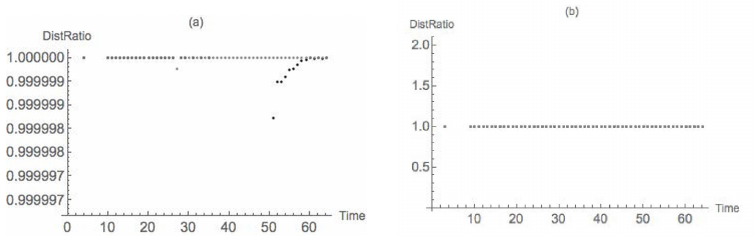
Figure 10. β 0 : Interpolation functions of ratios of bottleneck distance to Wasserstein-1 distance (black dots) and Wasserstein-2 distance (gray dots) for ( a ) Nx = 50 and ( b ) Nx = 100 triangulations.